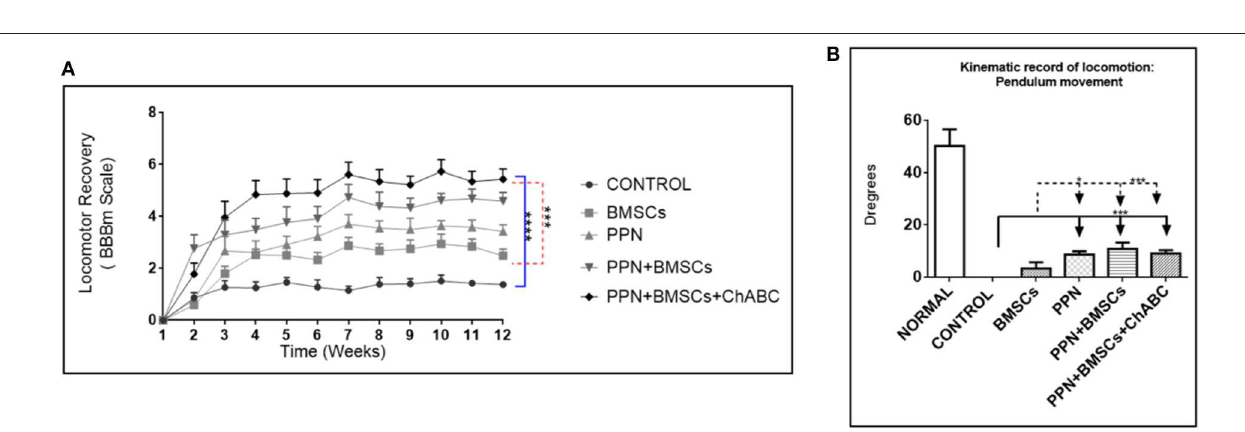
FIGURE 5 | Representative tracing images of the spinal cord. Rostral zone (A) and caudal zone (B) of the spinal cord show ascending fibers (red, mini-ruby dextran, tetramethylrhodamine) and descending fibers (green, emerald fluoro dextran fluorescein). These inmunofluorescence are representative of the staining of the neurotracers. Nuclei dyed in blue with Hoechst. Scale = 1,000 µ m.